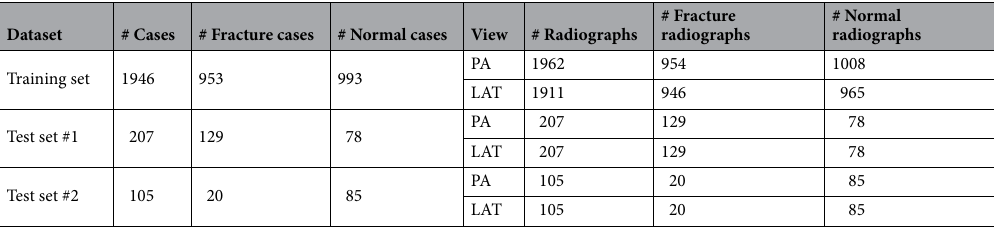
Table 1. Datasets used in this